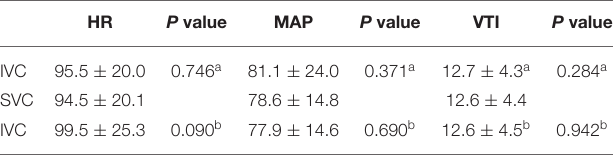
TABLE 2 | Hemodynamic parameters of